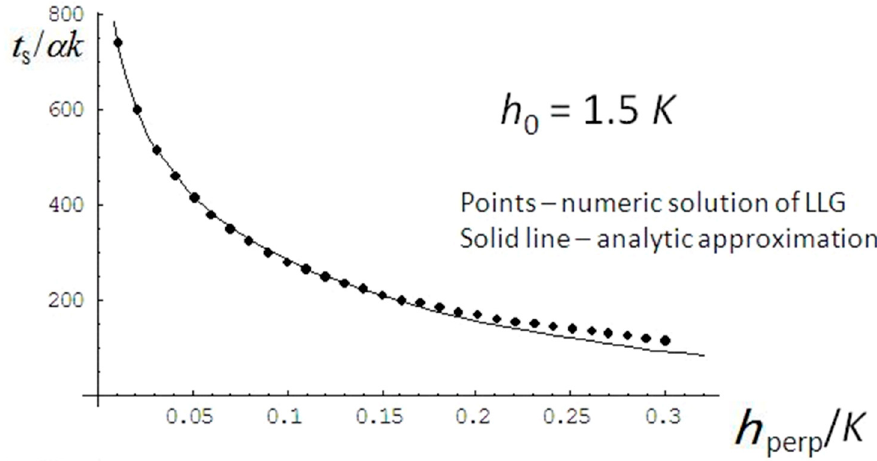
Figure 9. Magnetic switching time t s calculated using the numerical approach (points) and analytical method (solid line) is shown as a function of the bias field h perp applied along the ( π /2, 0) direction in the context of the switching field ( h 0 = 1.5 × K ) supplied along the − z axis in addition to the initial angle determined to be h perp × ( h 0 + K ) − 1 .